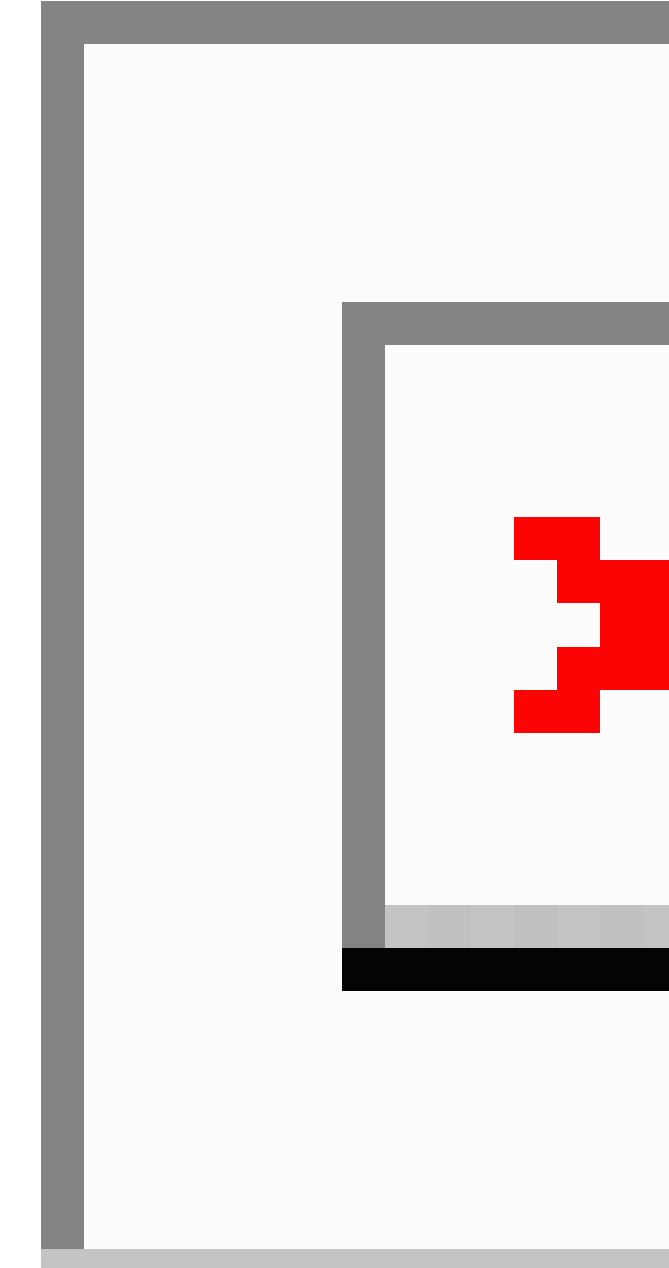
C1 = ‘Alarm, on’, ‘Bathroom, on’, ‘Shower, on’, ‘Shower off’, ‘Bathroom off’ ‘Kitchen, on’, ‘Breakfast, on’, ‘Pill, on’, ‘Kitchen off’ C2 = ‘Alarm, on’, ‘Bathroom, on’, ‘Shower, on’, ‘Shower off’, ‘Bathroom off’ ‘Kitchen, on’, ‘Breakfast, on’, ‘Kitchen off’ C3 = ‘Alarm, on’, ‘Bathroom, on’, ‘Shower, on’, ‘Shower off’, ‘Bathroom off’ ‘Kitchen, on’, ‘Pill, on’, ‘Breakfast, on’, ‘Kitchen